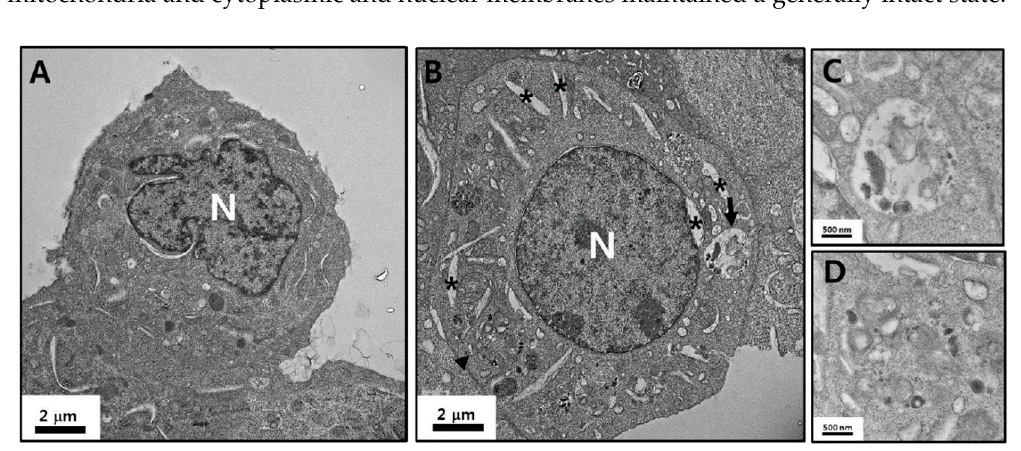
Figure 3. TEM images of astrocyte morphology. TEM images of astrocytes treated with phosphate-buffered saline (PBS) ( A ) and astrocytes incubated with ZnO NPs at a concentration of 3 μ g/mL for 24 h ( B ). ( C , D ) are magnified images of the arrow and arrowhead in ( B ), respectively. The black arrow and arrowhead indicate autophagolysosomes induced by ZnO NPs. * Swelling of the endoplastic reticulum (ER). N: nucleus.